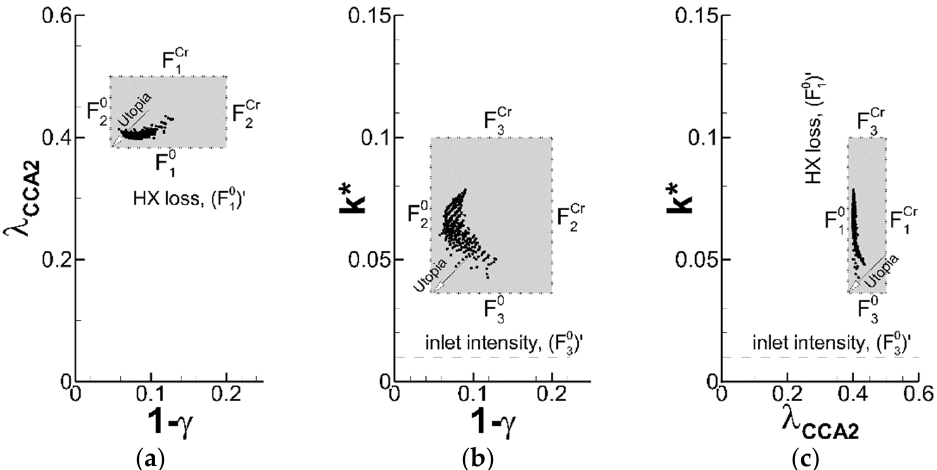
Figure 22. DoE 2 results—Projected 3D criterion space into three individual 2D components ( a – c ).